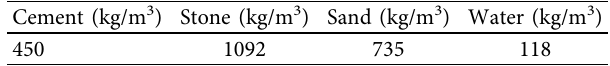
Figure 8: Sensors setting. Table 1: Mix proportion of concrete for specimens.